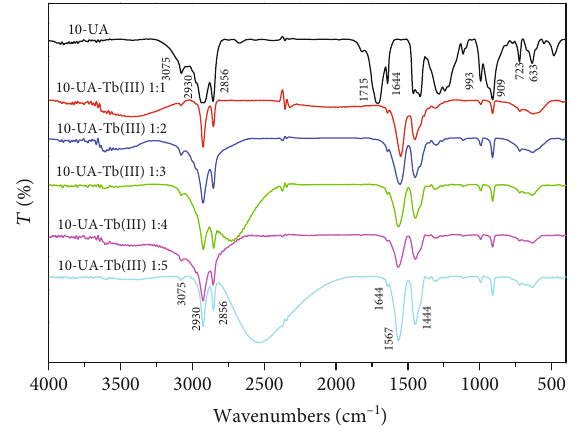
Figure 2: FTIR spectra of 10-UA and 10-UA-Tb(III)